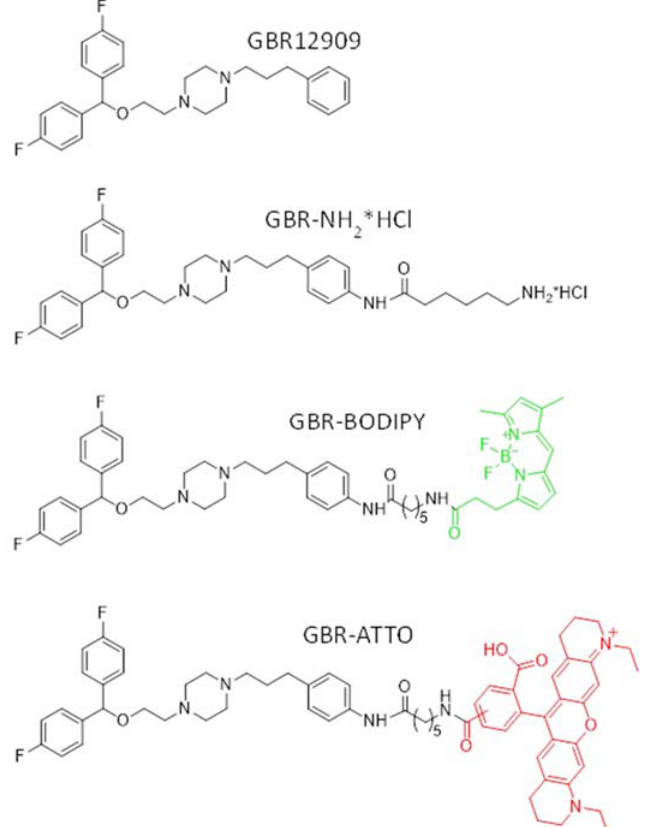
Figure Figure 1. Structures of 1 ‐ (2 ‐ (bis(4 ‐ fluorophenyl)methoxy)ethyl) ‐ 4 ‐ (3 ‐ phenylpropyl)piperazine (GBR ‐ 12909) and its modified (GBR ‐ NH 2 *HCl) and fluorescent analogs GBR–BODIPY (GBR ‐ BP) (green—BODIPY fluorophore) (Modified from [30]) and GBR ‐ ATTO (red—ATTO fluorophore).